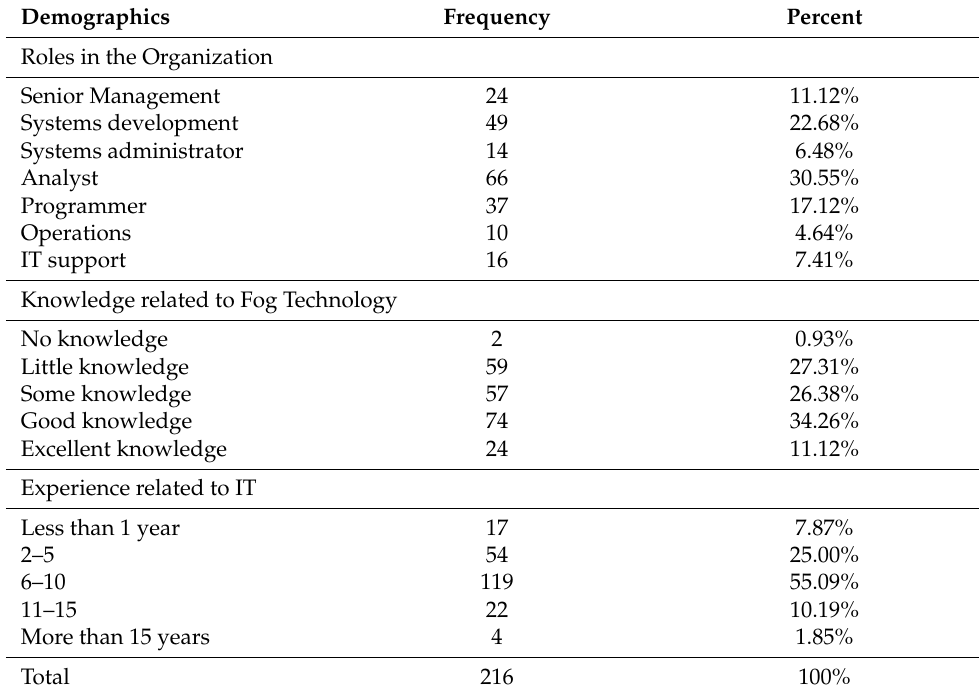
Figure 2. Organizations’ fog adoption stages. Table 3. Sample demographics (N =